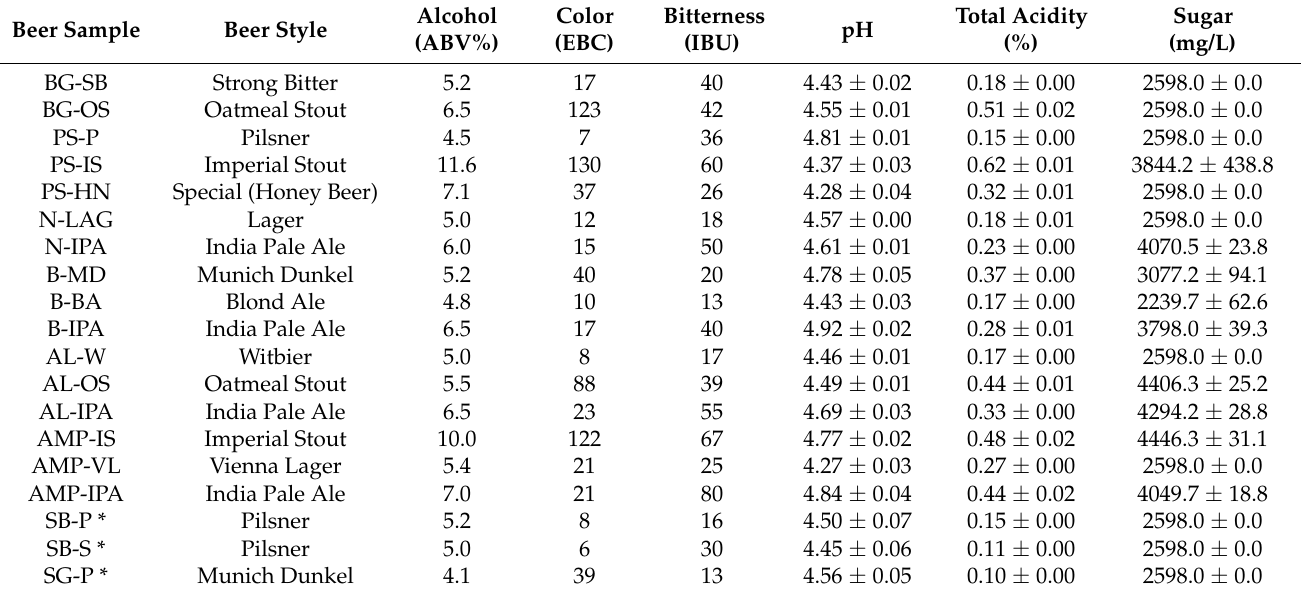
Table 1. Principal chemical parameters of each analyzed